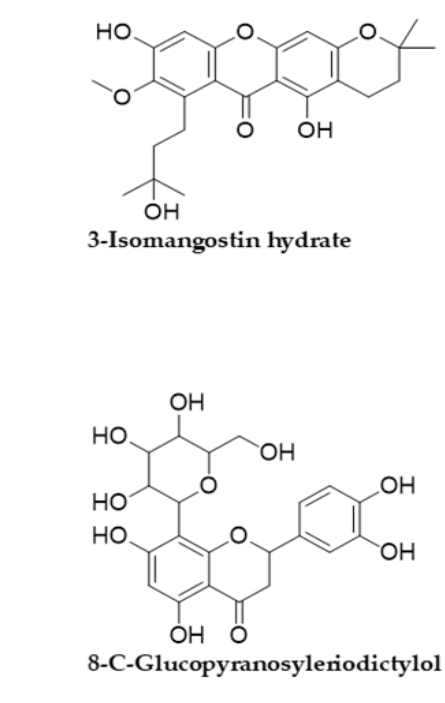
Figure 2. 2D structures of the tentative compounds identified by Q-ToF-LCMS analysis.